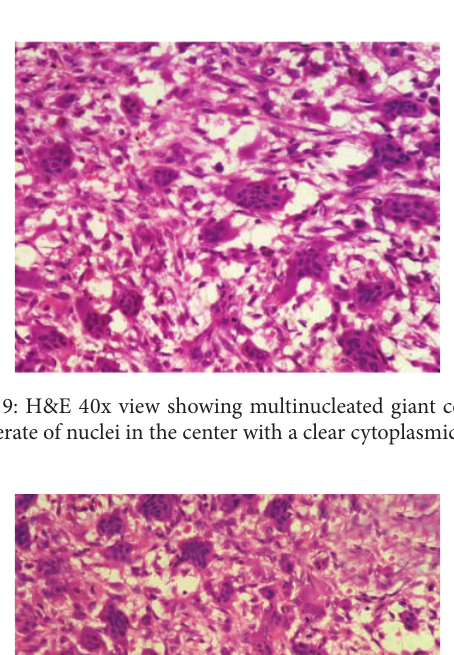
Figure 8: H&E 10x view overlying epithelium, connective tissue capsule, neoplastic areas showing proliferation of stromal cells, and multinucleated giant cells.